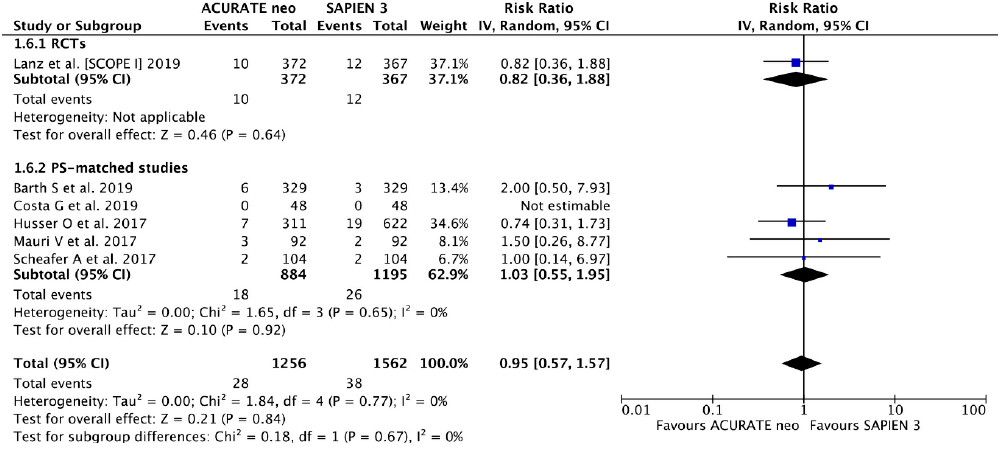
Figure A9. Clinical outcomes. Individual and summary risk ratios with corresponding 95% confidence intervals for the comparison of ACURATE neo and SAPIEN 3 in the analysis of